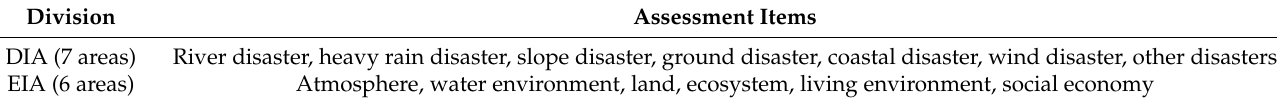
Table 2. Major DIA and EIA assessment items in